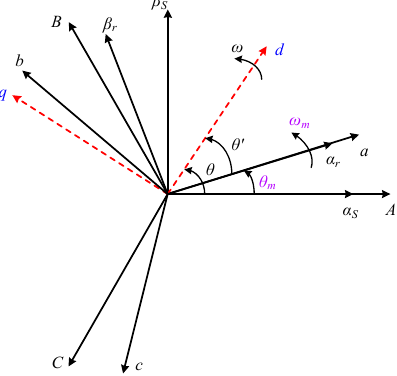
Figure 2. Relationships among reference frames.